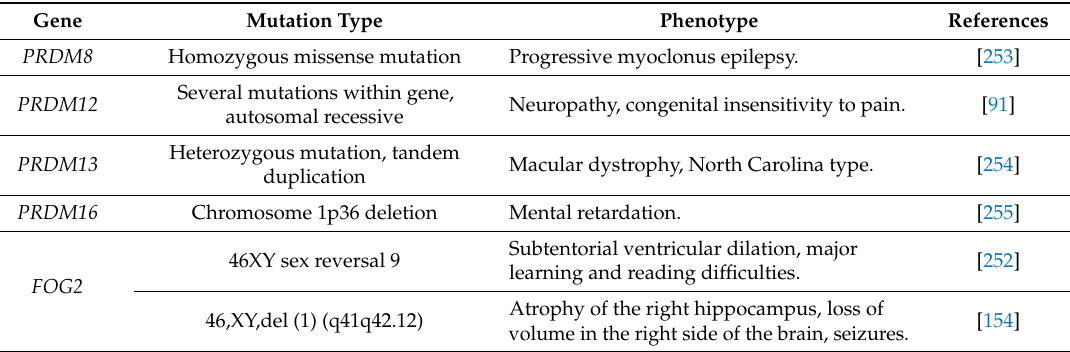
Table 4. Clinical e ff ect of mutation in PRDM genes within the neurological